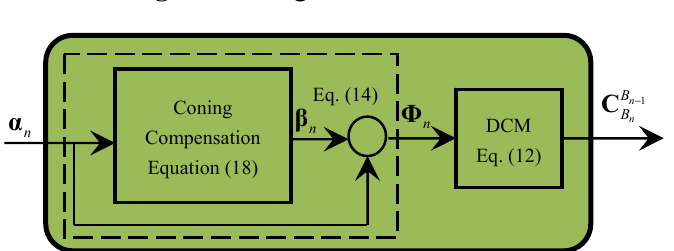
Figure 3. Diagram of module